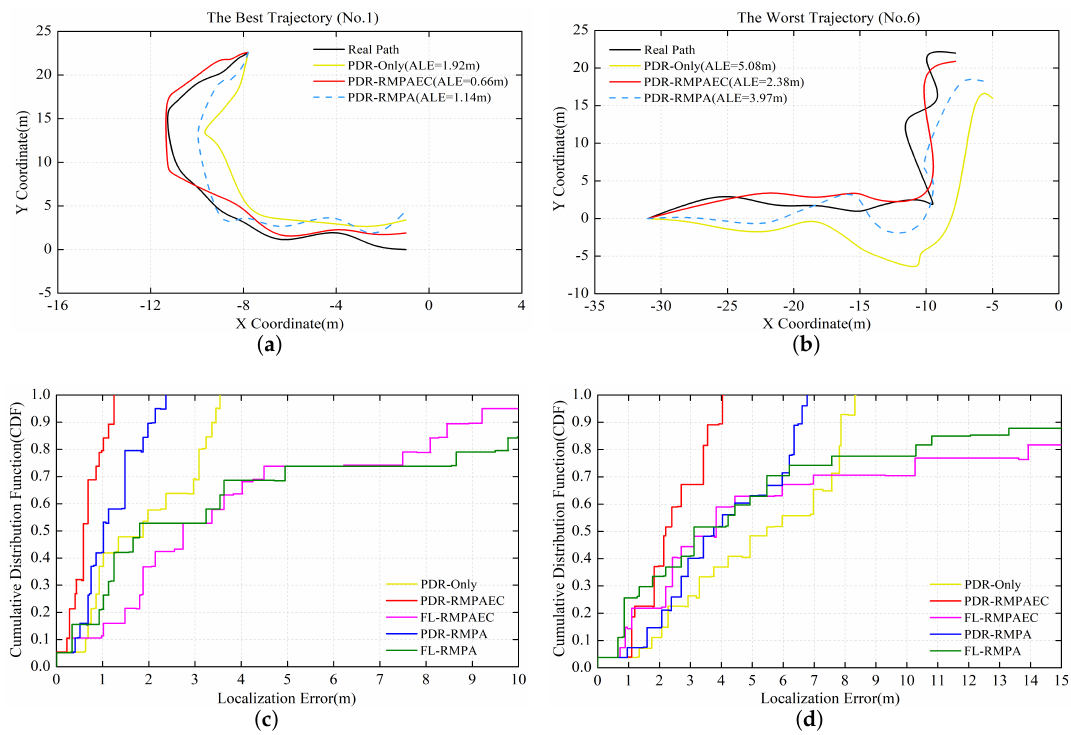
Figure 11. Localization results of testing paths in Experimental Area B: ( a ) The best No. 1 PDR-RMPAEC trajectory with ALE = 0.66 m; ( b ) the worst No. 6 PDR-RMPAEC trajectory with ALE = 2.38 m; and ( c ) CDF of localization error of the No. 1 trajectory; ( d ) CDF of localization error of the No. 6